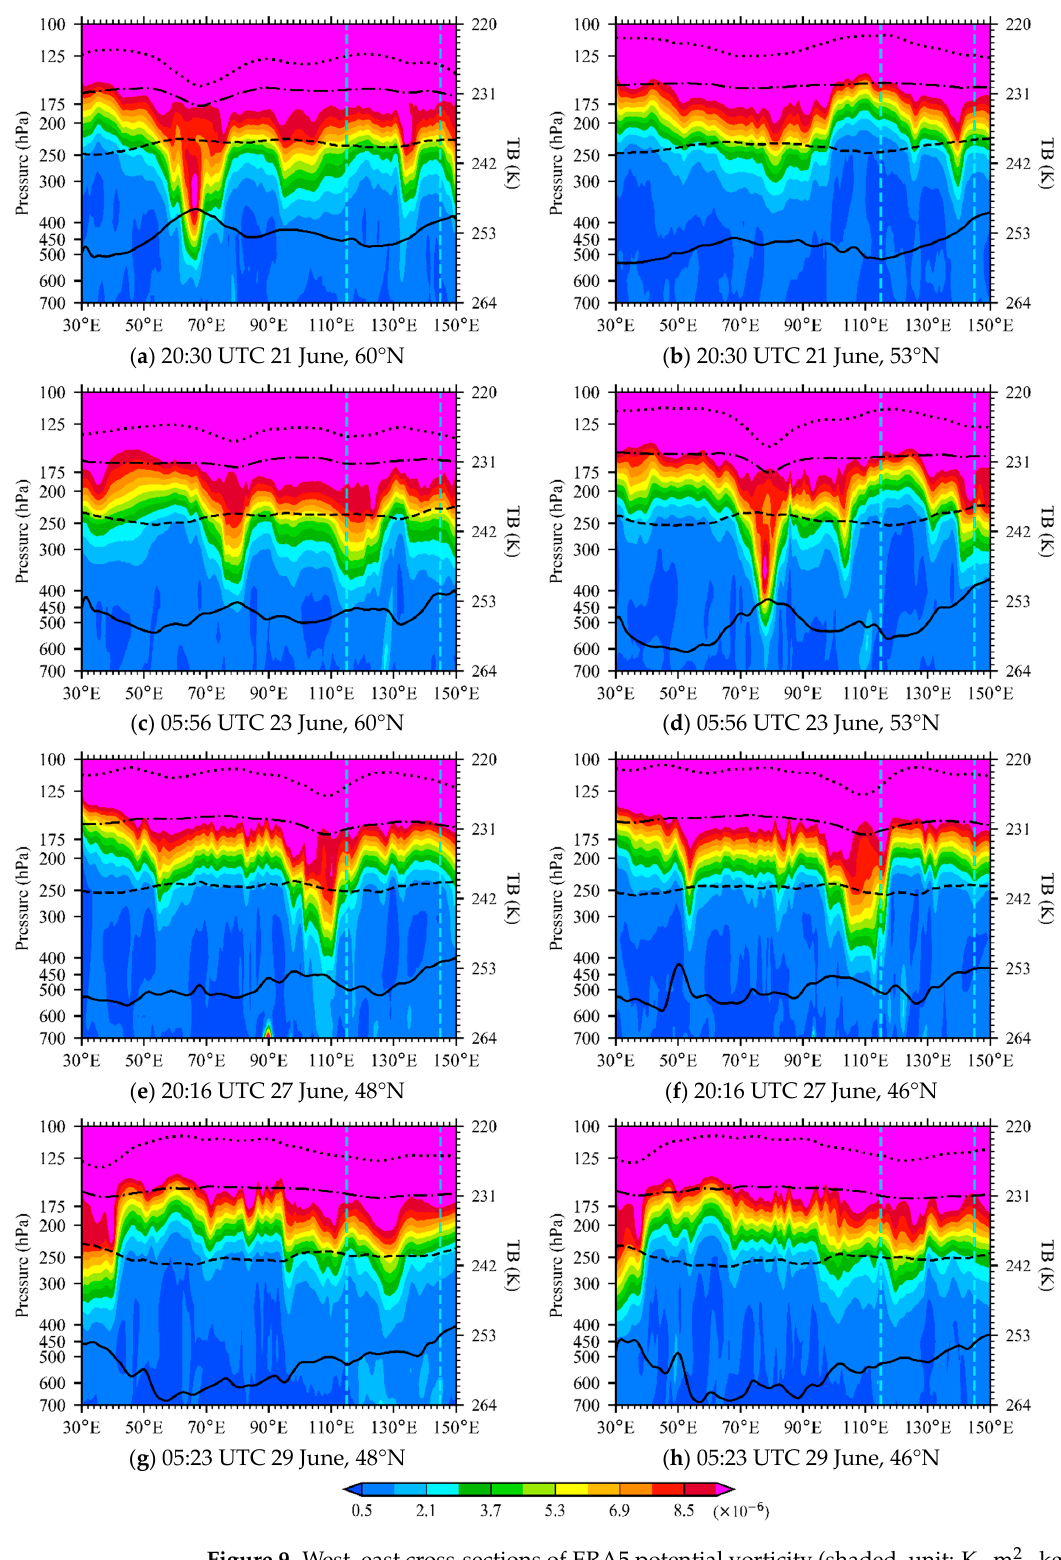
Figure 9. West–east cross-sections of ERA5 potential vorticity (shaded, unit: K · m 2 · kg − 1 · s − 1 ) and MWTS-2 brightness temperature (curves, unit: K) of channel 4 (solid), 5 (dashed), 6 (dash dotted), and 7 (dotted) at 60 ◦ N, 53 ◦ N, 48 ◦ N, and 46 ◦ N. Cyan dashed lines show the range of NCCV domain. Note that the Y -axis on the right is reversed.